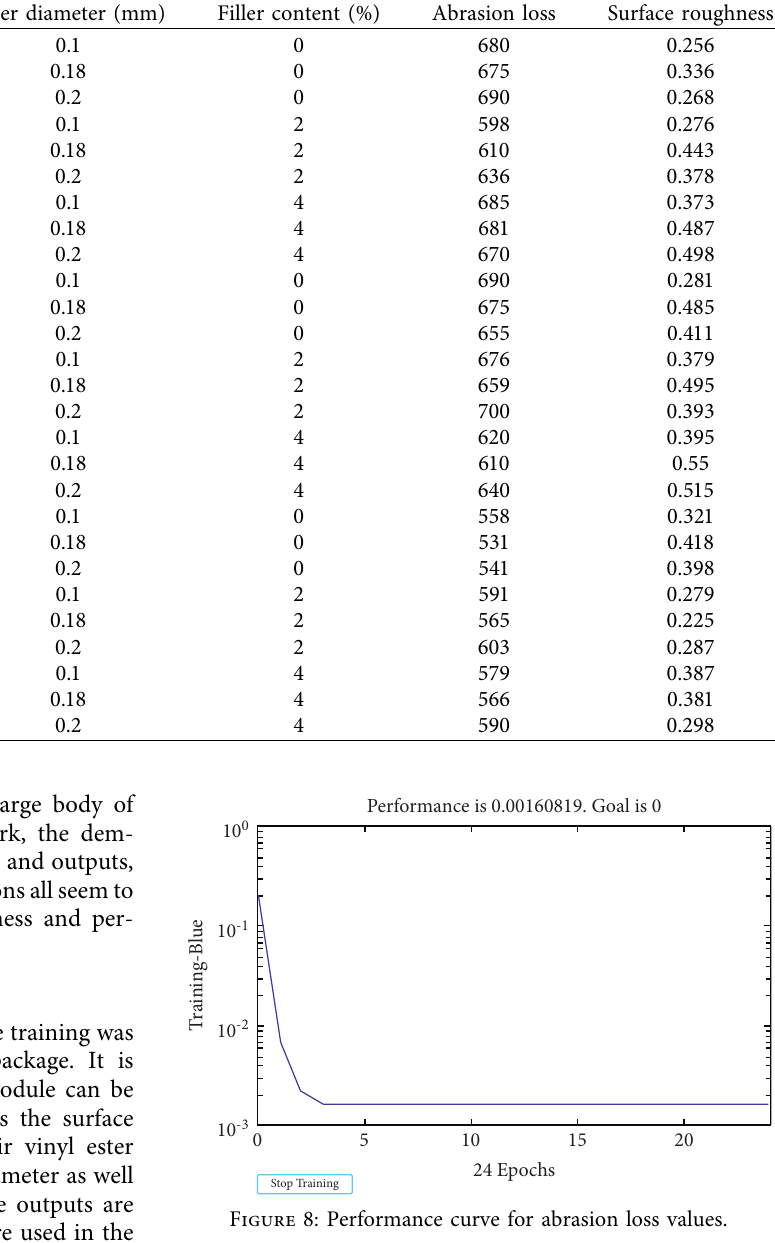
Table 2: Experimental results for carapace filler-filled coir vinyl ester composites. Sample specimen